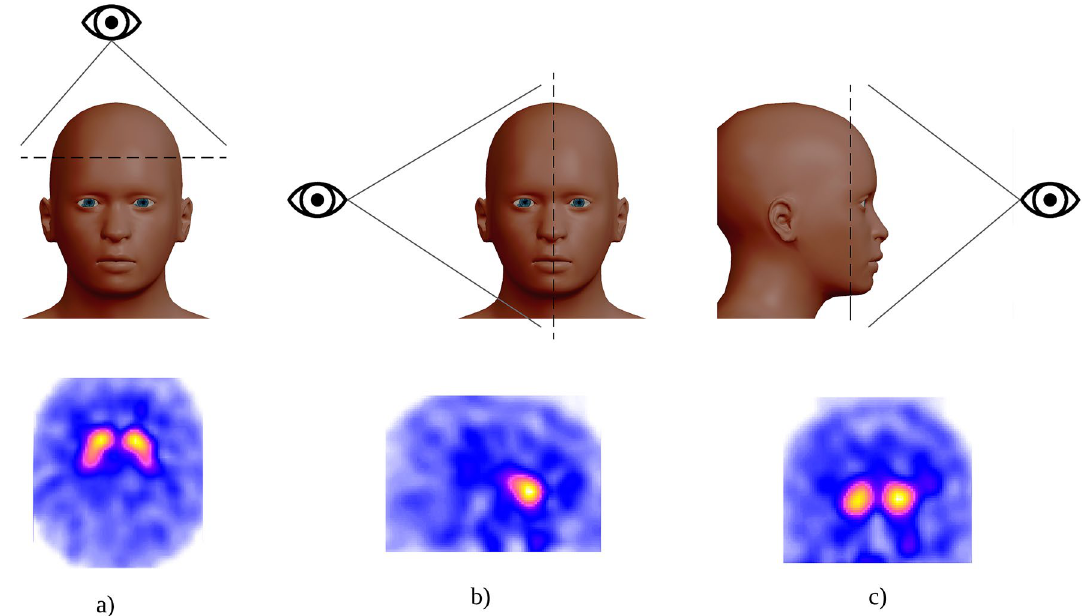
Figure 3. How are the cuts performed? ( a ) axial, ( b ) sagittal, and ( c ) coronal.